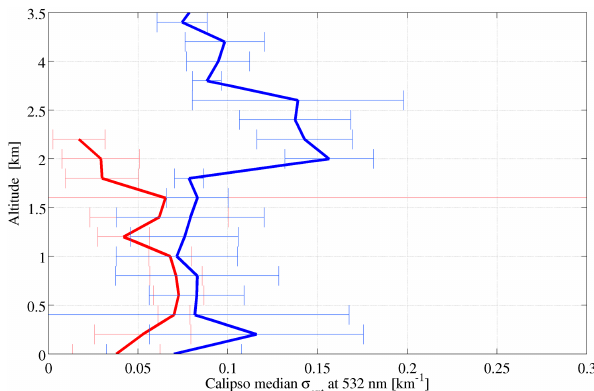
Figure 6. Median CALIPSO extinction profiles for days when MODIS AOD > 0.15 (blue) and AOD ≤ 0.15 (red). The CALIPSO profiles are collected within 50km radius from the Marikana sta- tion. The horizontal bars represent the interquartile ranges. The me- dian extinction profile for MODIS AOD ≤ 0.15 cases extends only up to 2.2km because the quality of the data above 2.2km was too